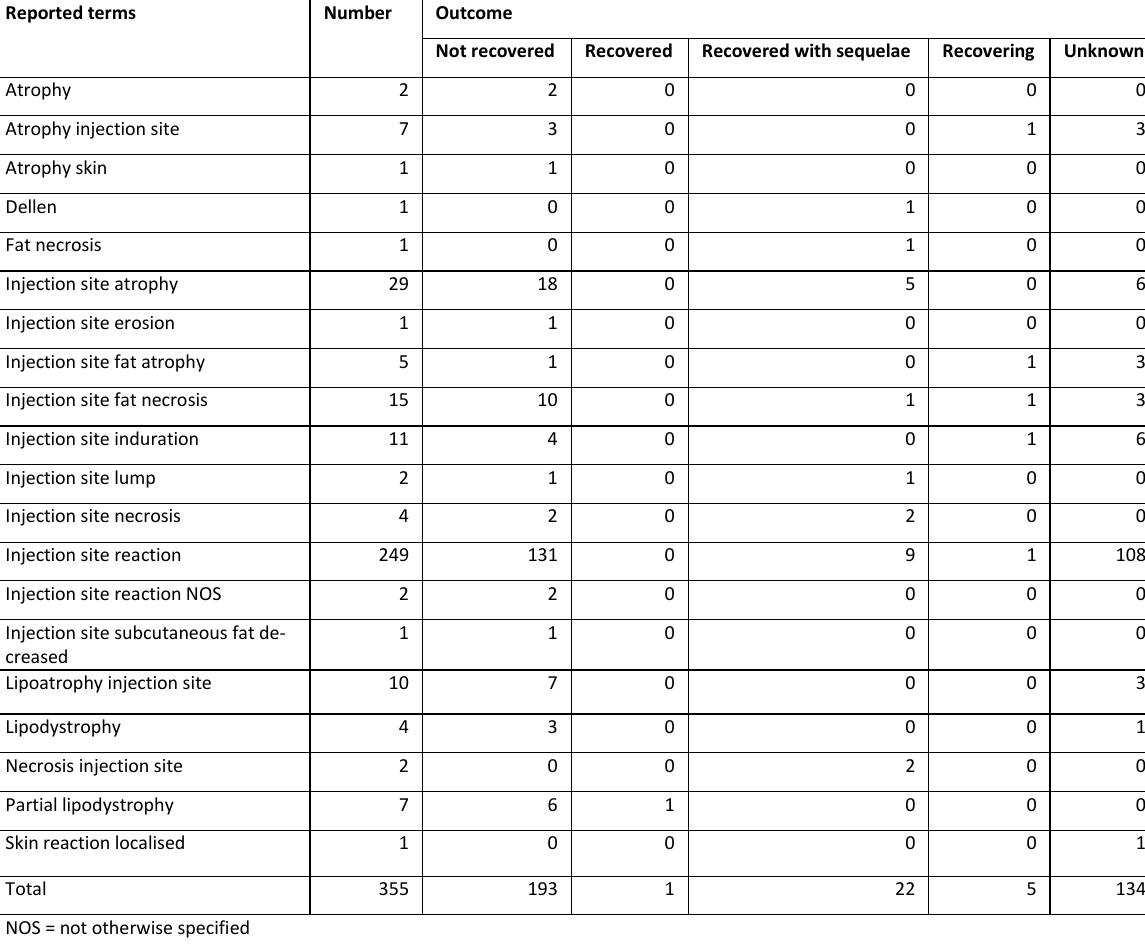
Table 1: Reported terms and outcome of adverse drug reactions corresponding to 323 international individual case safety reports. Reported